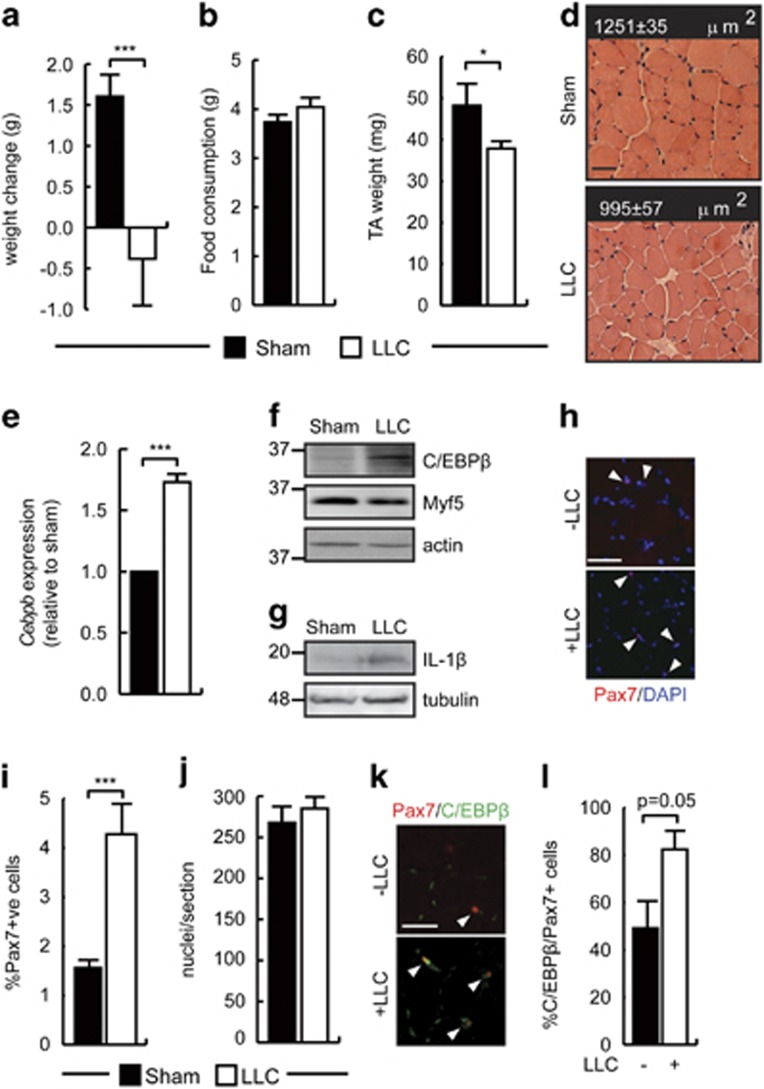
Cancer cachexia increases C/EBPβ expression in SCs and inhibits myogenesis. (a) Average weight gain of female C57BL/6 sham and LLC-injected mice (8 weeks old) 4 weeks after grafting. ***P=0.001, n=15. (b) Average daily food consumption of sham and LLC tumor grafted animals. (c) Average TA mass in healthy and cachectic mice as in (a). *P<0.05, n=5. (d) H&E-stained TA cross-sections from sham and LLC-bearing mice 4 weeks after grafting. Mean fiber cross-sectional areas (XSA) are indicated±S.E.M.. P=0.006, n=5. Scale bar=20 μm. (e)
Cebpb expression in primary myoblasts isolated from healthy and cachectic mice. Freshly isolated cells were plated at equal densities and expanded in culture for 3 days without passaging before analysis. ***P=0.001, n=6. (f) C/EBPβ expression in primary myoblasts isolated from healthy and LLC-bearing mice. Freshly isolated cells were plated at equal densities and expanded in culture for 3 days without passaging before analysis. Actin is a loading control. (g) IL-1β expression in TA muscle of sham and LLC-bearing mice. The migration of molecular weight markers, in kDa, is shown. Tubulin is a loading control. (h) Representative images of immunohistochemistry for Pax7 expression in TA muscle isolated from mice as in (a). Scale bar=50 μm. Arrowheads indicate positively stained cells. (i) Percentage of Pax7+ cells (relative to total nuclei) in TA muscle isolated from mice as in (a). ***P<0.001, n=6. (j) Quantification of nuclei per section of TA muscle as in (i). (k) Representative images of Pax7 and C/EBPβ immunostaining on TA muscle sections from animals treated as in (a). Scale bar=20 μm. Arrowheads indicate double-positive stained cells. (l) Percentage of C/EBPβ/Pax7+ cells (relative to total Pax7+ cells) in TA muscle from healthy and cachectic mice from (k). n>3